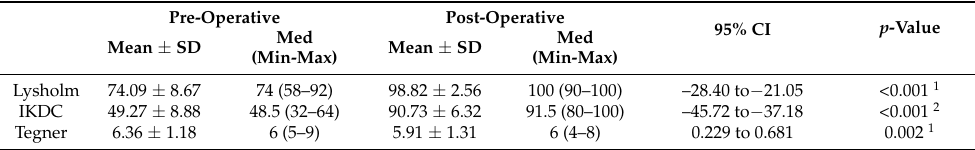
Table 2. Pre- and post-operative functional knee outcome scores (Lysholm, IKDC and Tegner).